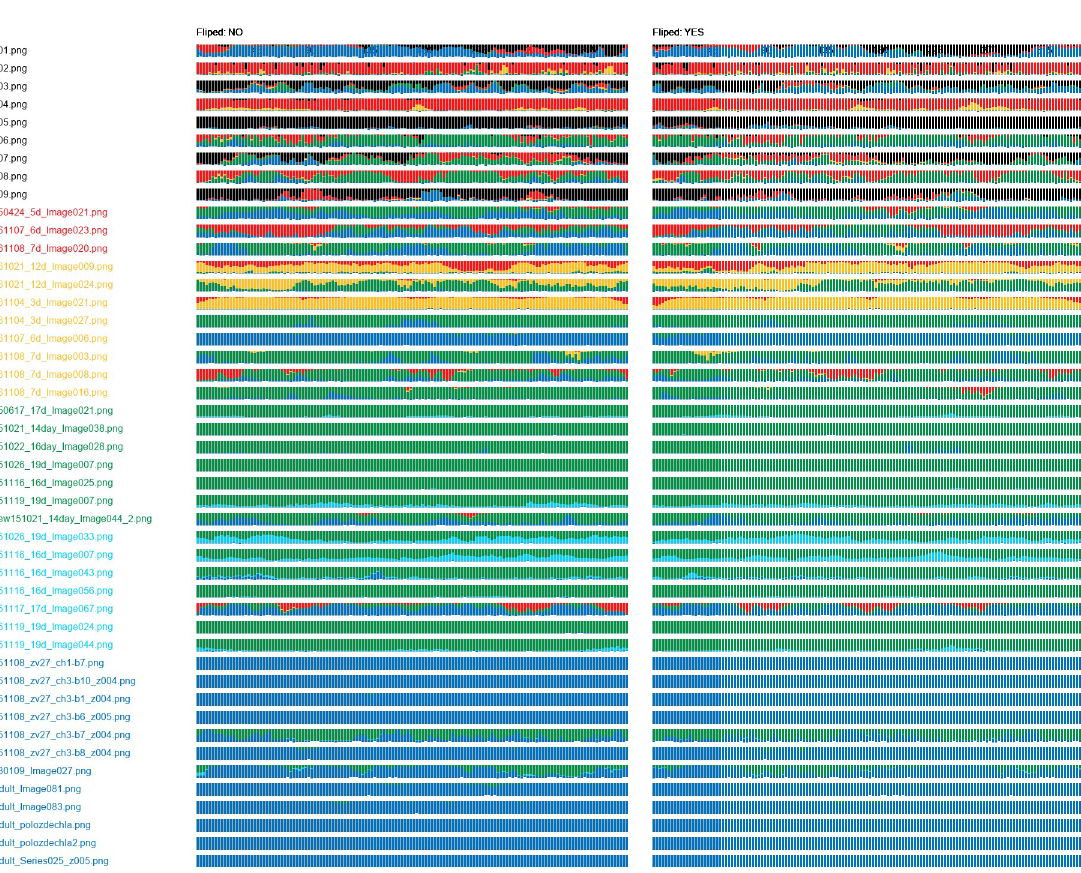
Fig 8. Class probability graph obtained for the DenseNet-512 trained on T-512-B. The trained network almost correctly recognizes the class 5 but same samples of other classes are also labelled as class 5. The network tends to label samples of other classes as the class 3; however, some samples of the classes 0 to 4 are correctly